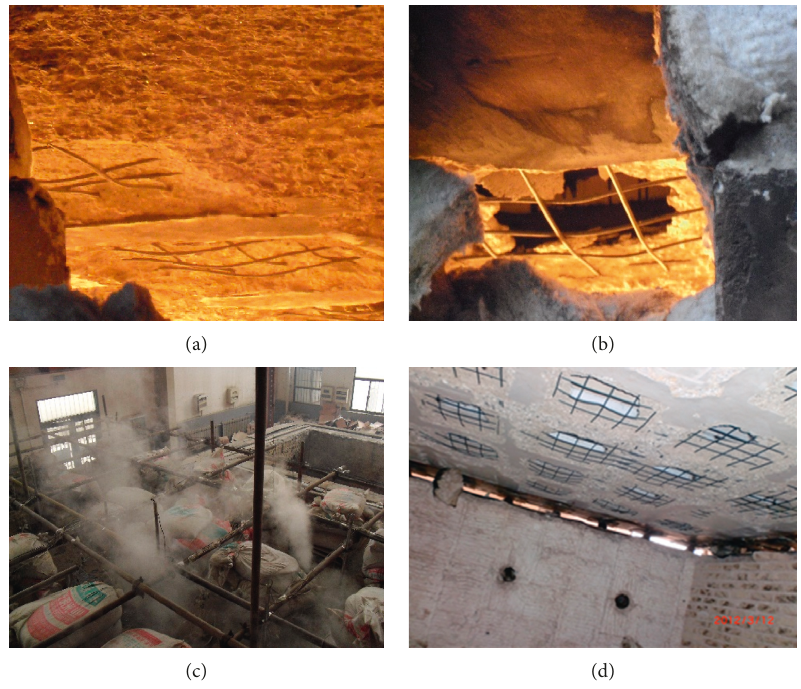
Figure 7: Fire test of the covered box. (a) 15 minutes. (b) 40 minutes. (c) 70 minutes. (d) 292